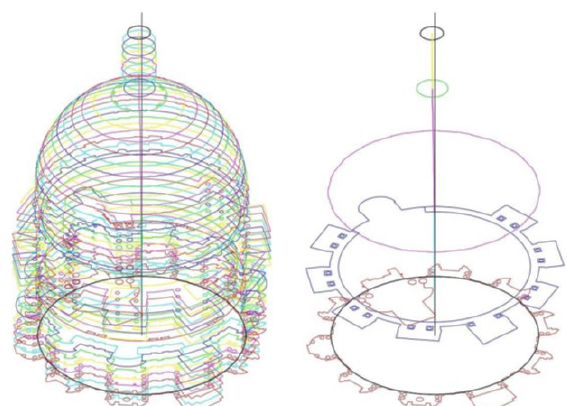
Figure 11. Axonometric view: the thin black line is vertical in the bottom